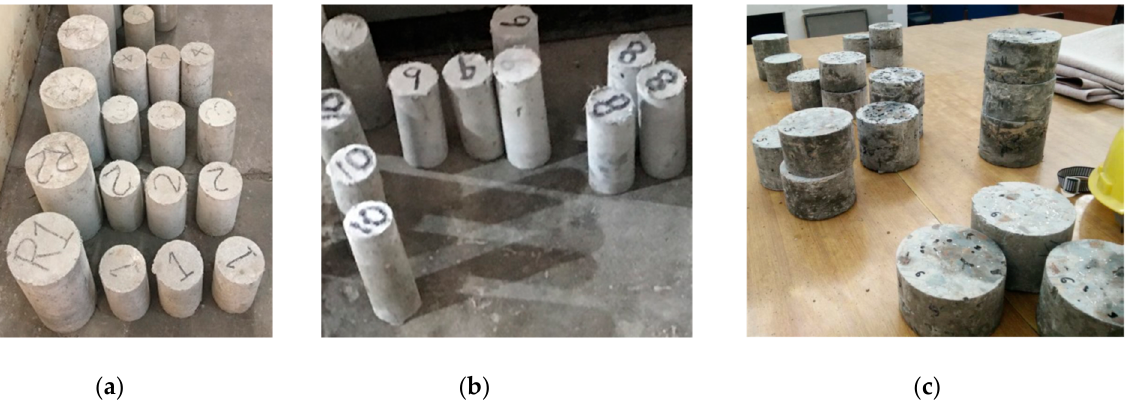
Figure 4. Hardened samples after 28 days curing ( a ) cylinder for compression strength and split cylinder test, ( b ) samples for the Charpy impact test, ( c ) cylindrical disks for the drop weight test.